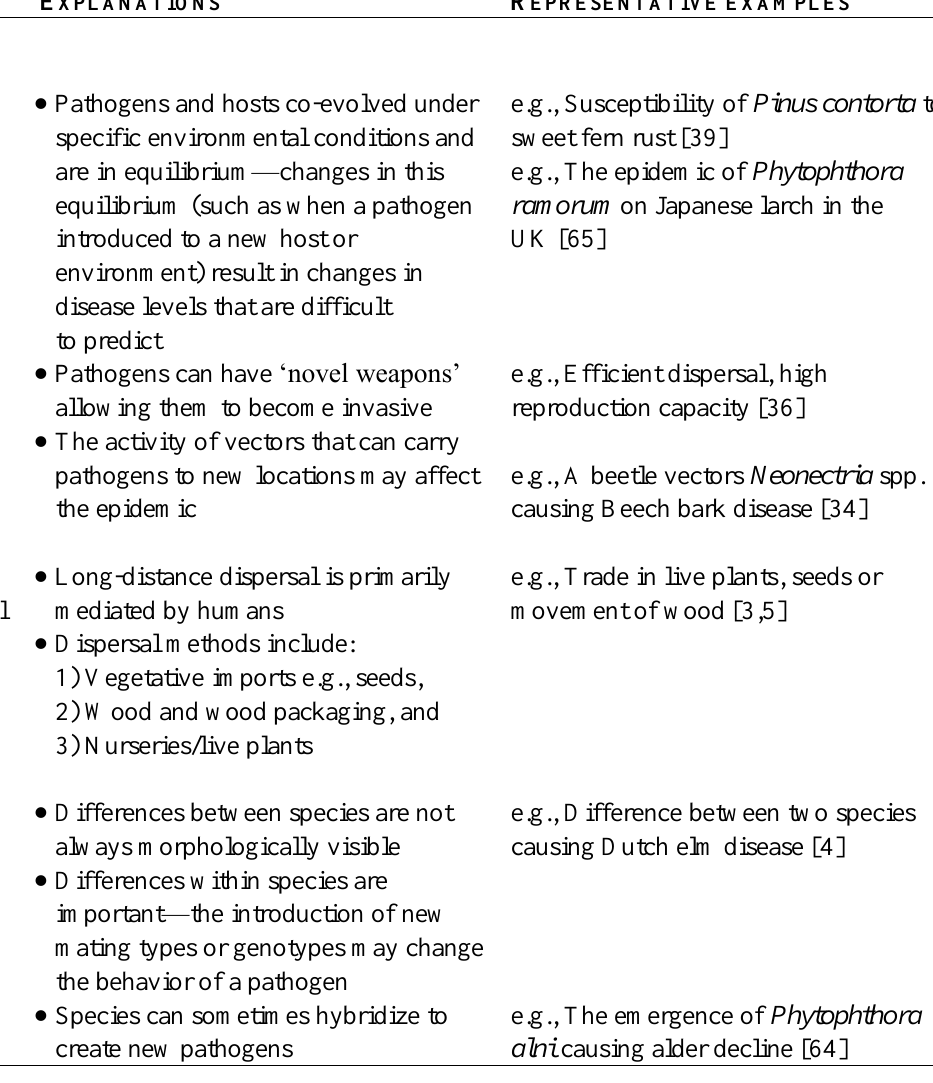
Table 1. A summary of the main concepts preventing more societal engagement in the prevention of emerging diseases in Europe. C